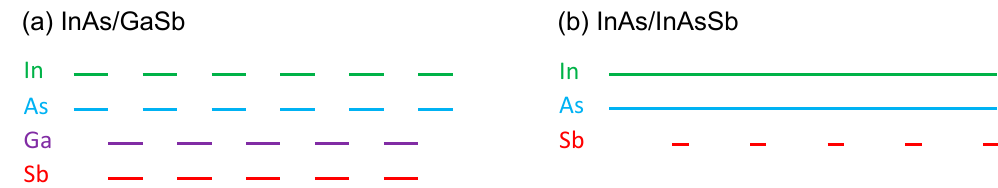
Figure 6. Schematic illustration of mechanical shutter sequences used in growing ( a ) InAs / GaSb and ( b ) InAs / InAsSb superlattices.